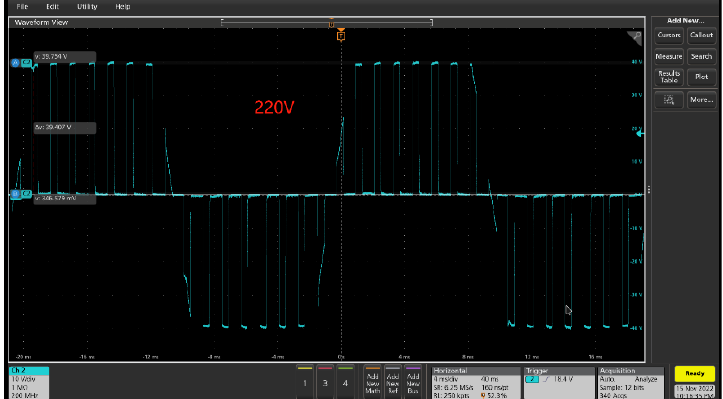
Figure 14. Characteristic current value 1 of practical test waveform.